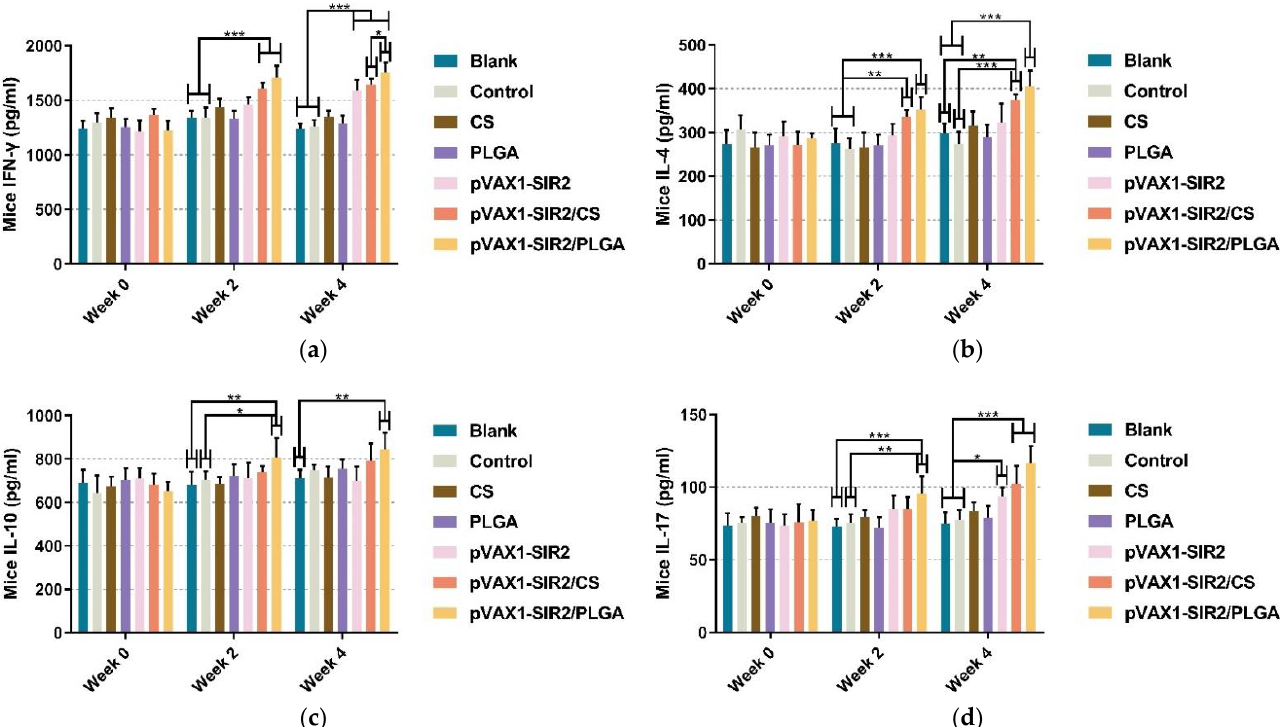
Figure 6. Cytokine secretions in animals. Using the commercial ELISA kits, the secretions of IFN- γ ( a ), IL-4 ( b ), IL-10 ( c ), and IL-17 ( d ) in animals’ sera were investigated at week zero, two, and four. Each serum was investigated once, and values were analyzed by one-way ANOVA analysis followed by Dunnett ’ s test. Values between the pVAX1-SIR2/CS and pVAX1-SIR2/PLGA group were estimated by the independent t -test. Values were shown as mean ± SD (n = 5). * p < 0.05, ** p < 0.01, and *** p < 0.001 compared with blank or control group.